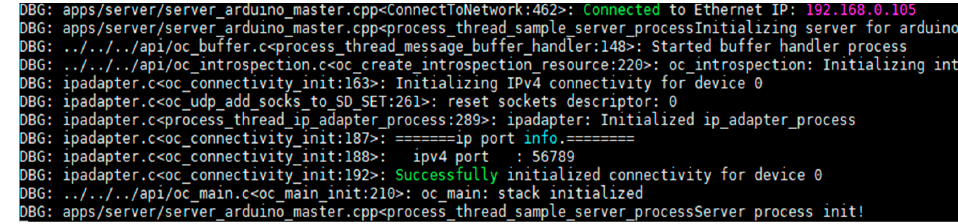
Figure 7. IoTivity HAN servers (appliance interface nodes): ( a ) AVR/ARM DAQ node prototype; ( b ) ESP32 node DAQ Prototypes.